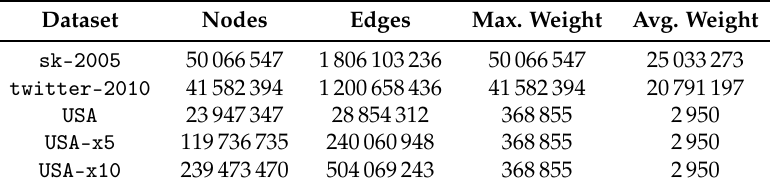
Table 1. Datasets used in the experimental evaluation.